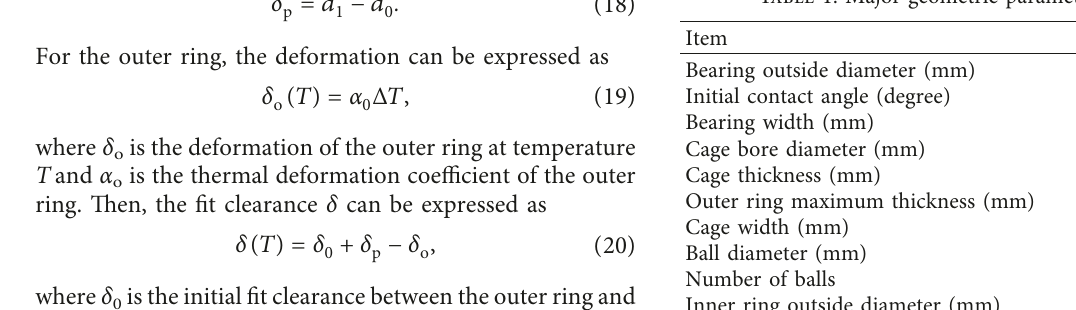
Table 1: Major geometric parameters of 7009C.